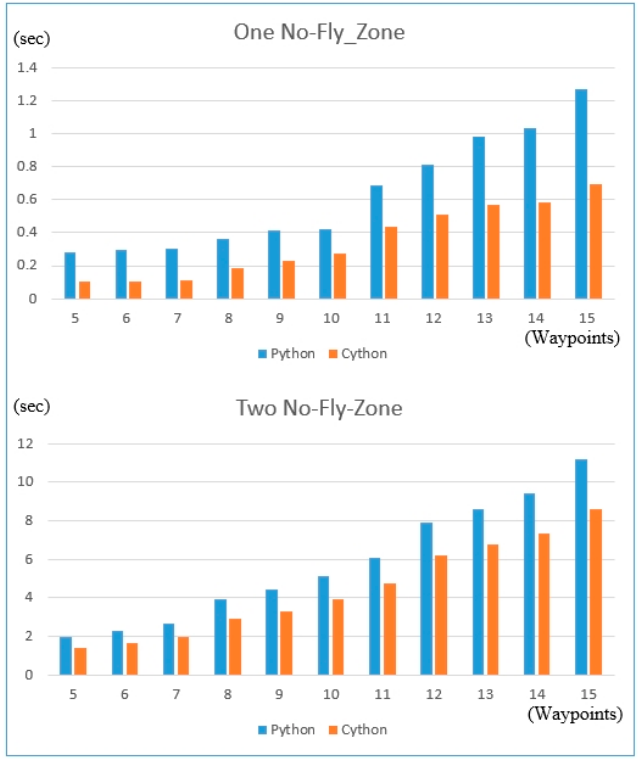
Figure 15. Comparison of Python and Cython on Jetson Xavier NX.